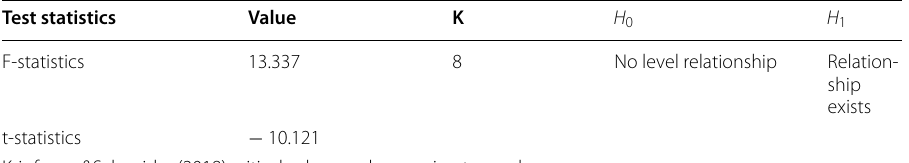
Table 6 ARDL bounds test analysis